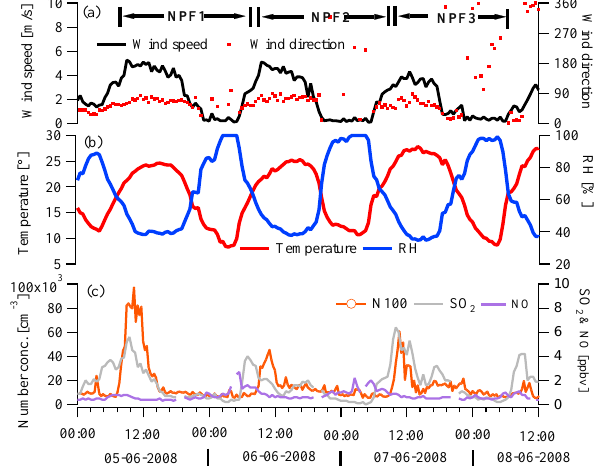
Figure 2. Time series of wind speed and wind direction (a) , ambi- ent temperature and RH (b) , and SO 2 and NO concentrations and number concentrations of particles in diameters of 3–100nm (c) . The starting and ending times of the events are marked at the top of (a) by NPF1, NPF2, and